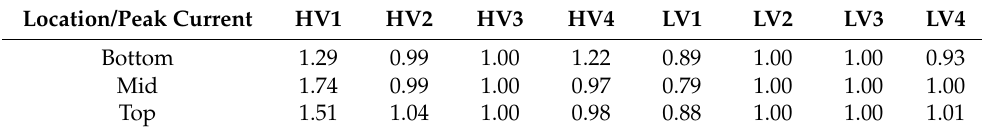
Table 3. The steady-state current multiple of each branch under different short-circuit positions. Location